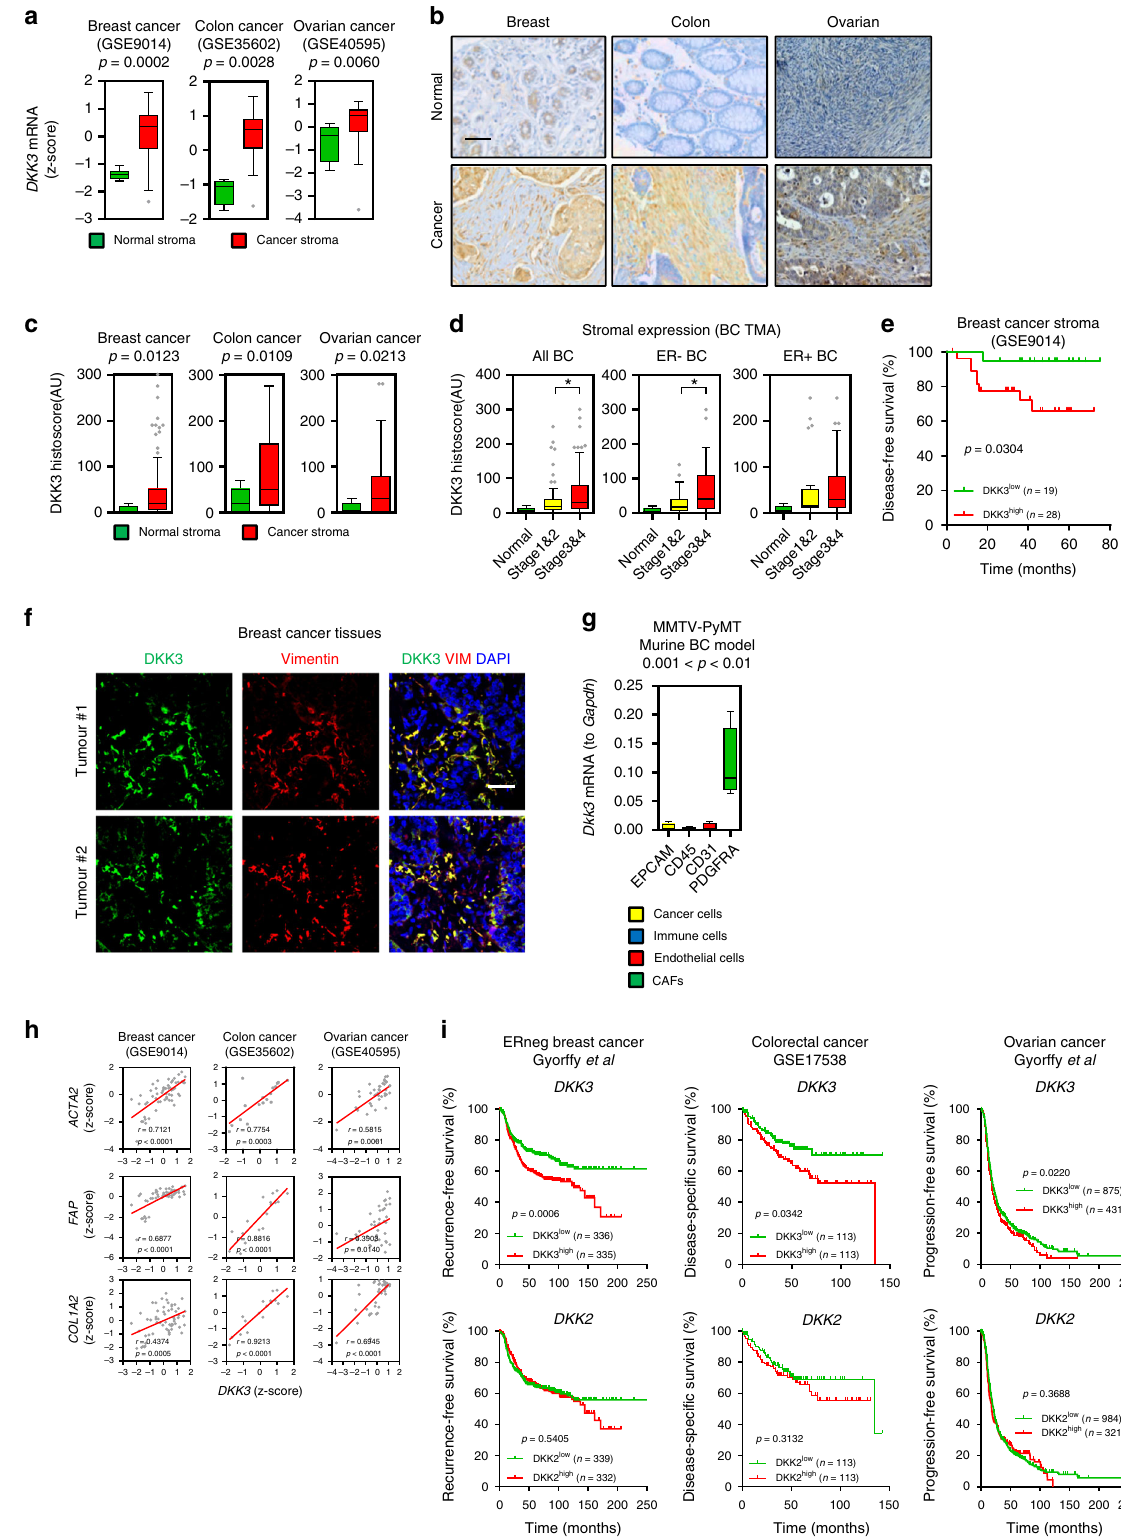
knockout CAFs (CAF-KO) and CAF-KO re-expressing Dkk3 (CAF-KO-REC)(Supplementary Figure 3b and Fig. 3f). Validat- ing our previous results, Dkk3-null CAFs presented signi fi cantly less ECM remodelling activity (Supplementary Figure 3c, d). In three-dimensional (3D) co-culture models 19 (Fig. 3g), CAFs